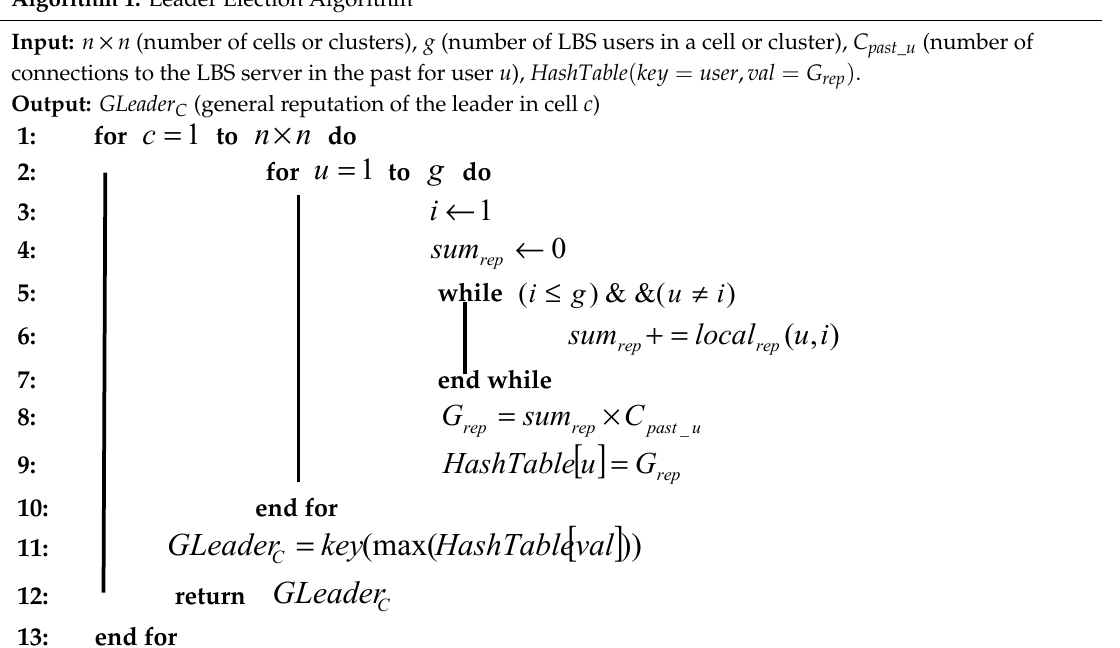
Algorithm 1: Leader Election Algorithm